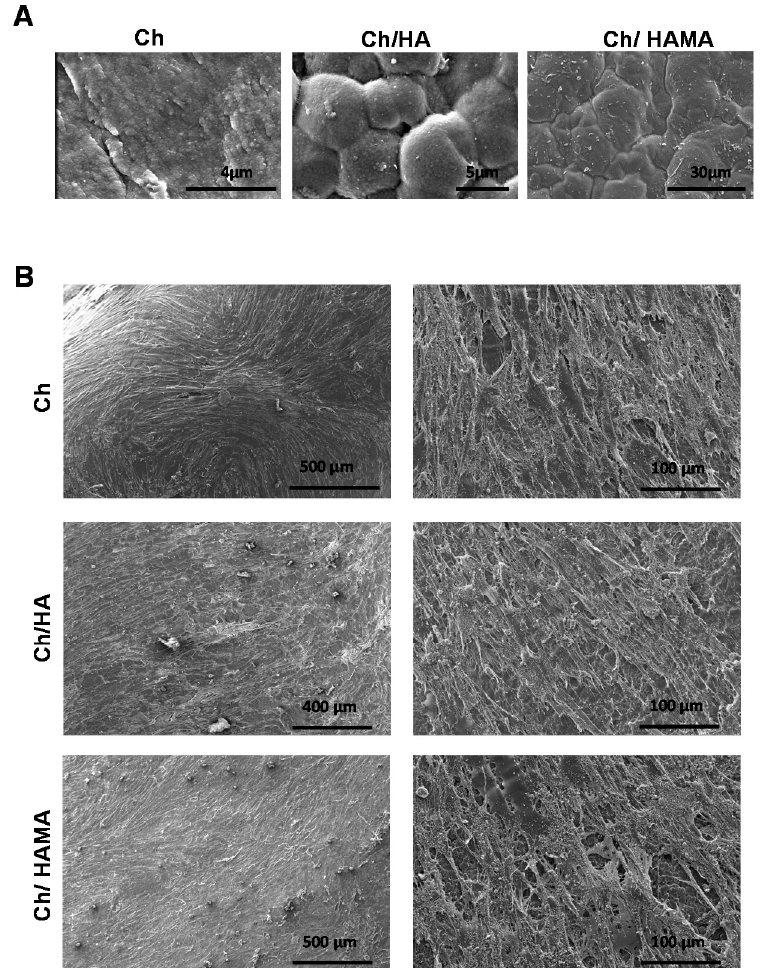
Figure 6. ESEM images of Ch, Ch / HA and Ch / HAMA hydrogel membranes. Representative ESEM images of hydrogel membranes before hMSCs culture ( A ). Representative ESEM images of hMSCs growing on hydrogel membranes after 21 days ( B ).